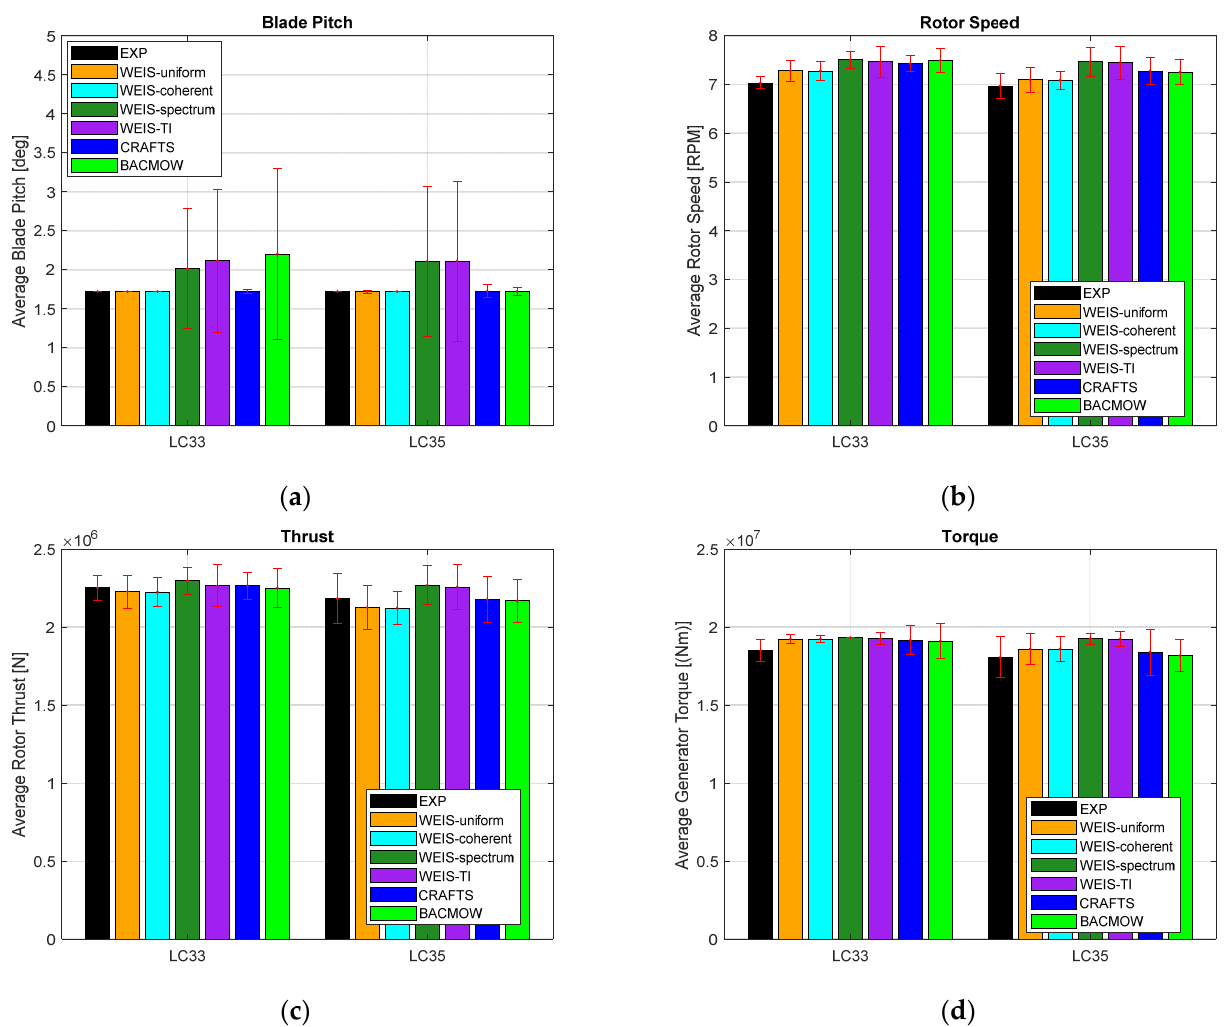
Figure 14. LC 3.3 and LC 3.5 metrics for ( a ) pitch, ( b ) rotor speed, ( c ) thrust, and ( d ) torque. Red error bars indicate twice the standard deviation about the mean .